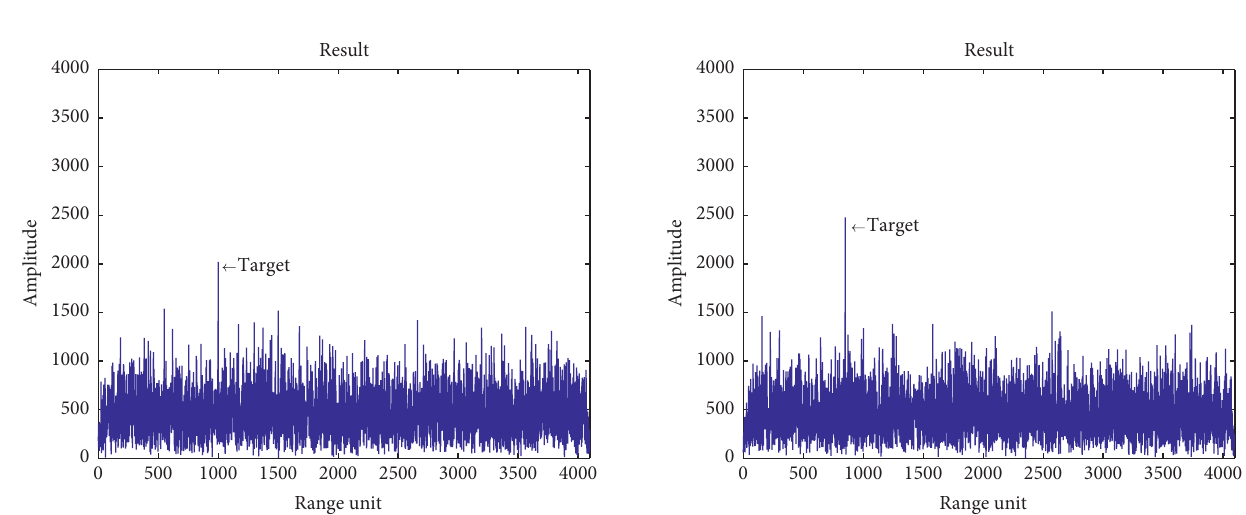
Figure 6: Result of adaptive dual-polarization filtering with active deception jamming.